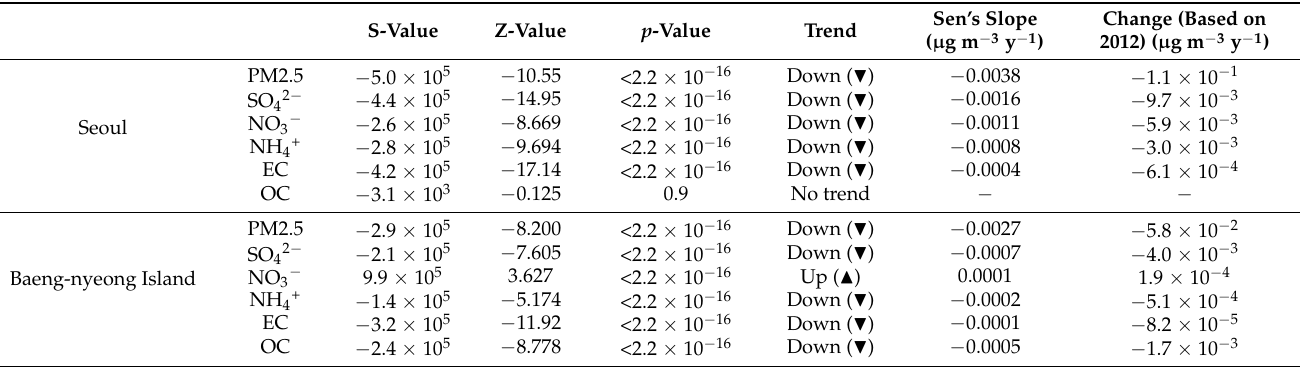
Sen’s Slope ( µ g m − 3 y − 1 )